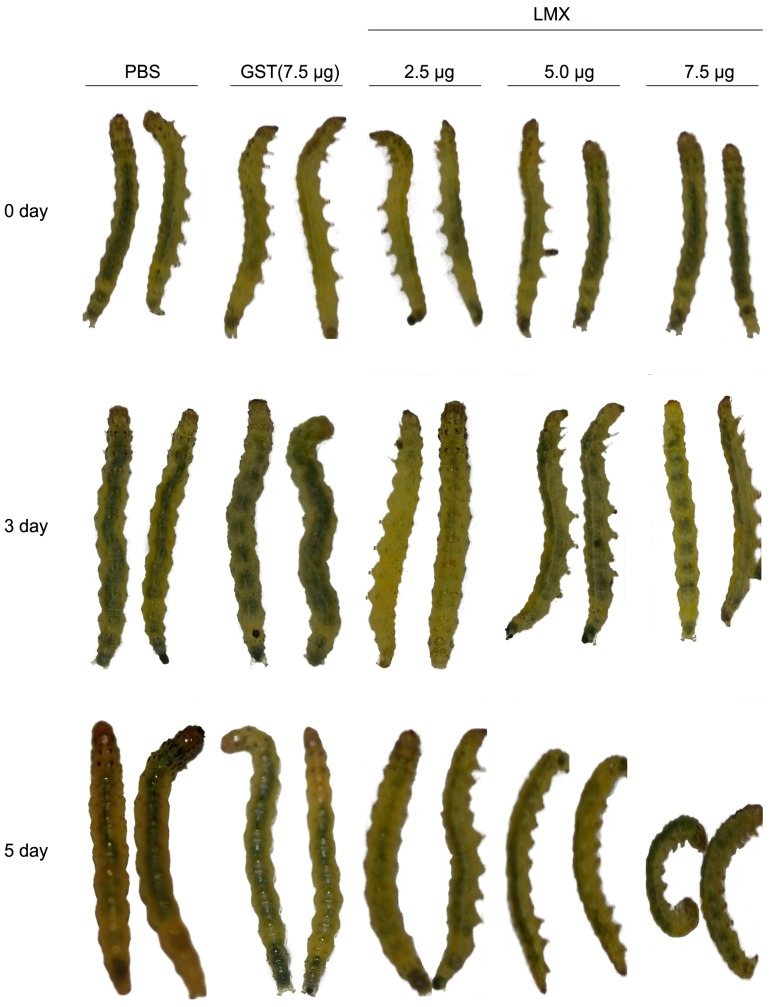
Phenotype of the rice leaf folder larvae fed with LMX protein.The larvae fed on 2.5 ∼7.5 µg LMX protein-applied rice leaves were treatment groups, while the larvae fed on PBS buffer-applied rice leaves and 7.5 µg GST tag protein-applied rice leaves were control groups. Pictures were taken at the start (0 days), 3 days, and 5 days.